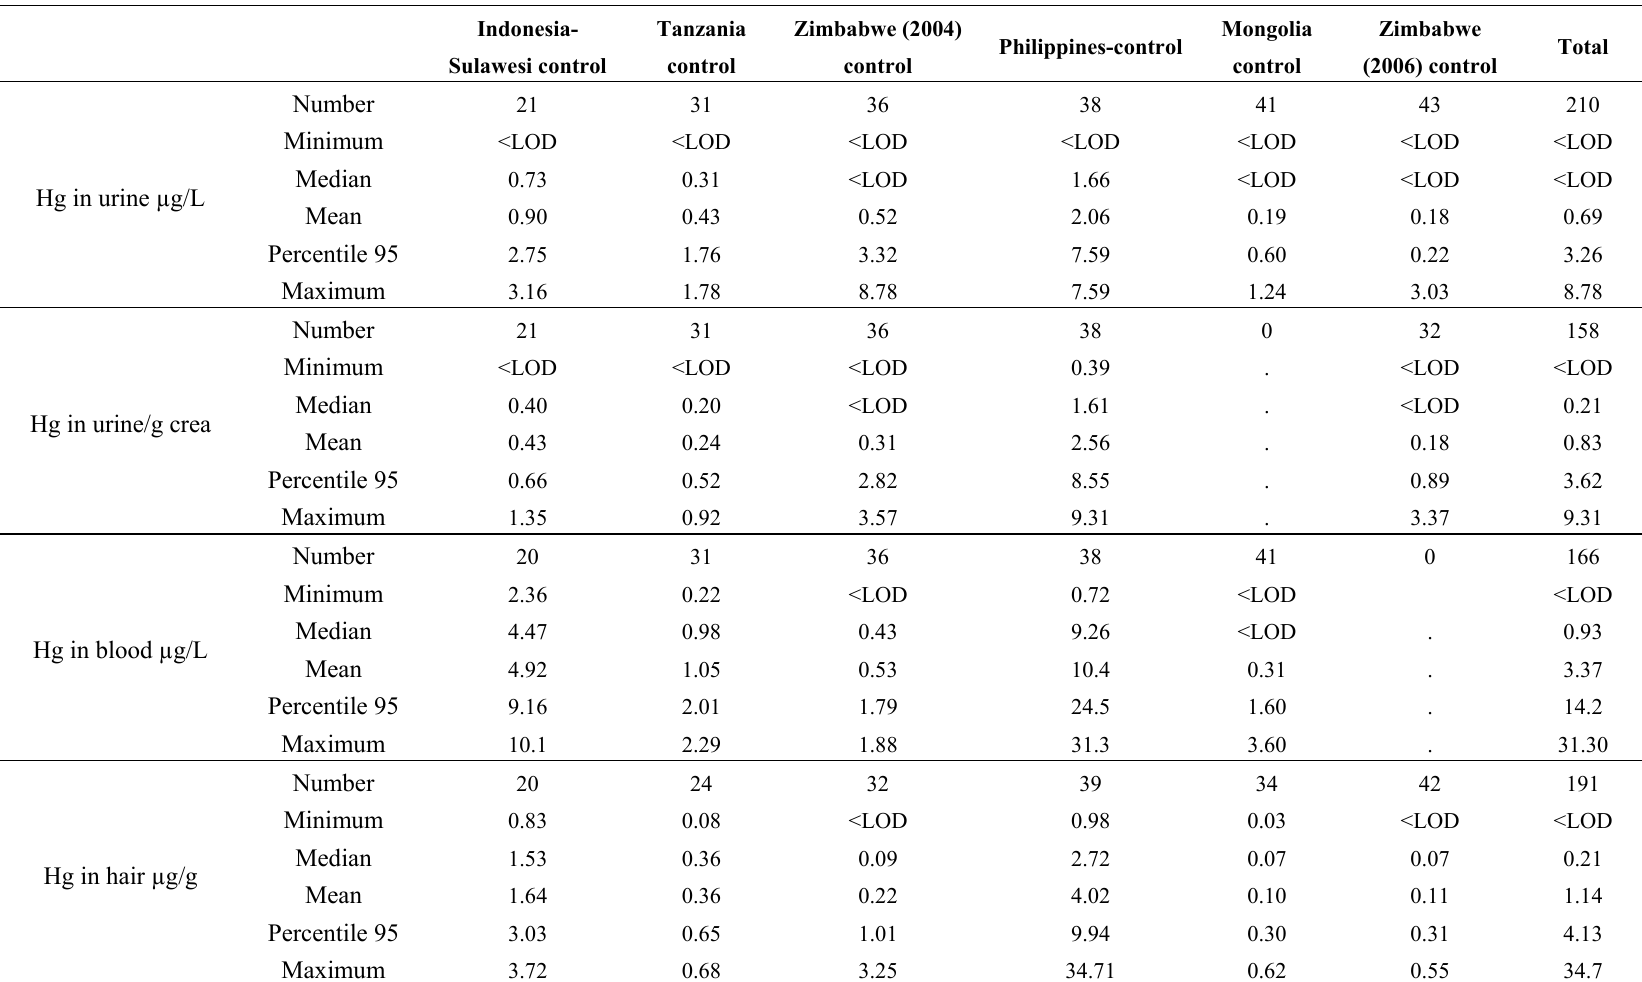
Table 3. Mercury in human specimens for the not exposed control